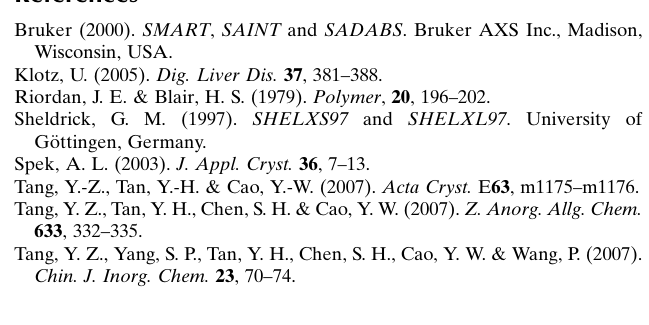
Experimental Crystal data